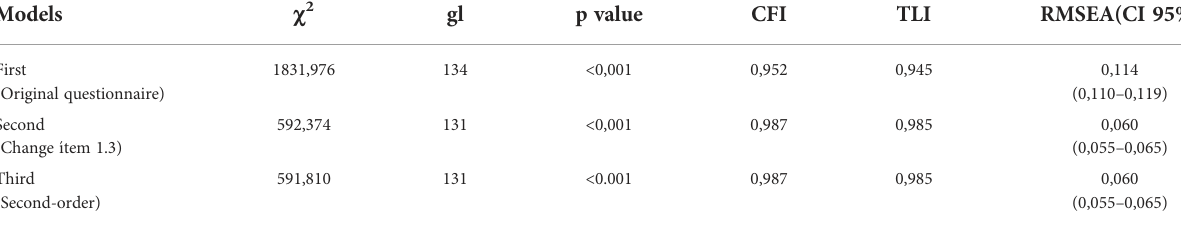
TABLE 2 Fit indices in the three tested models of the SES-PSSP questionnaire (n = 969).